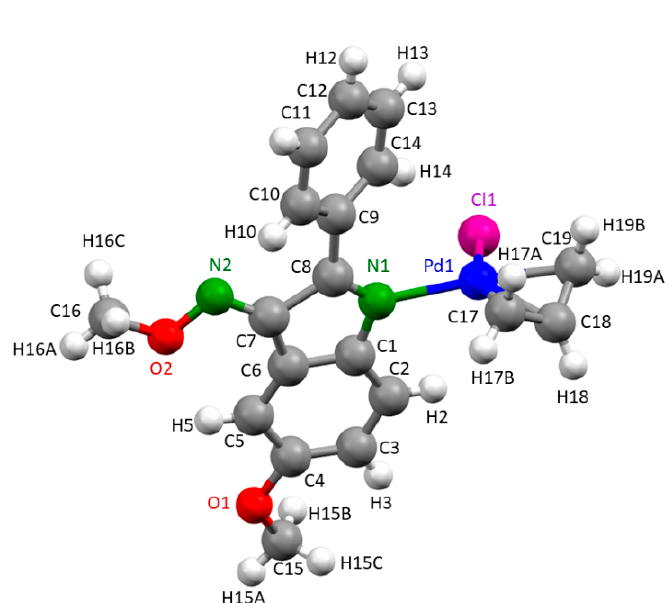
Figure 4. Molecular structure of [Pd( η 3 -C 3 H 5 ){C 8 H 3 N-2-(C 6 H 5 )-3-NOMe-5-(OMe)}Cl] ( 2a ). Selected bond lengths (in Å) and angles (in deg.): Pd1-Cl1, 2.4815(11); Pd1-N1, 2.124(4); Pd1-C17, 2.189(6); Pd1-